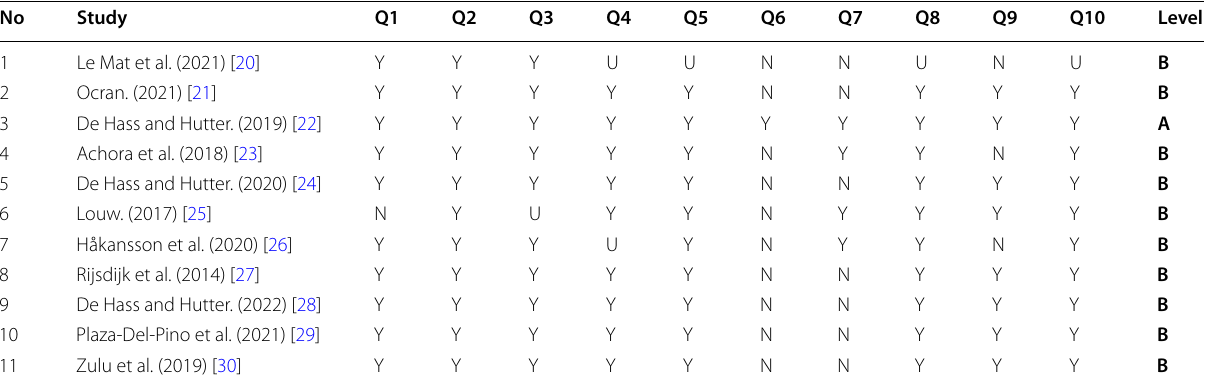
Table 4 Quality appraisal of the included studies (Joanna Briggs Institute Critical Appraisal